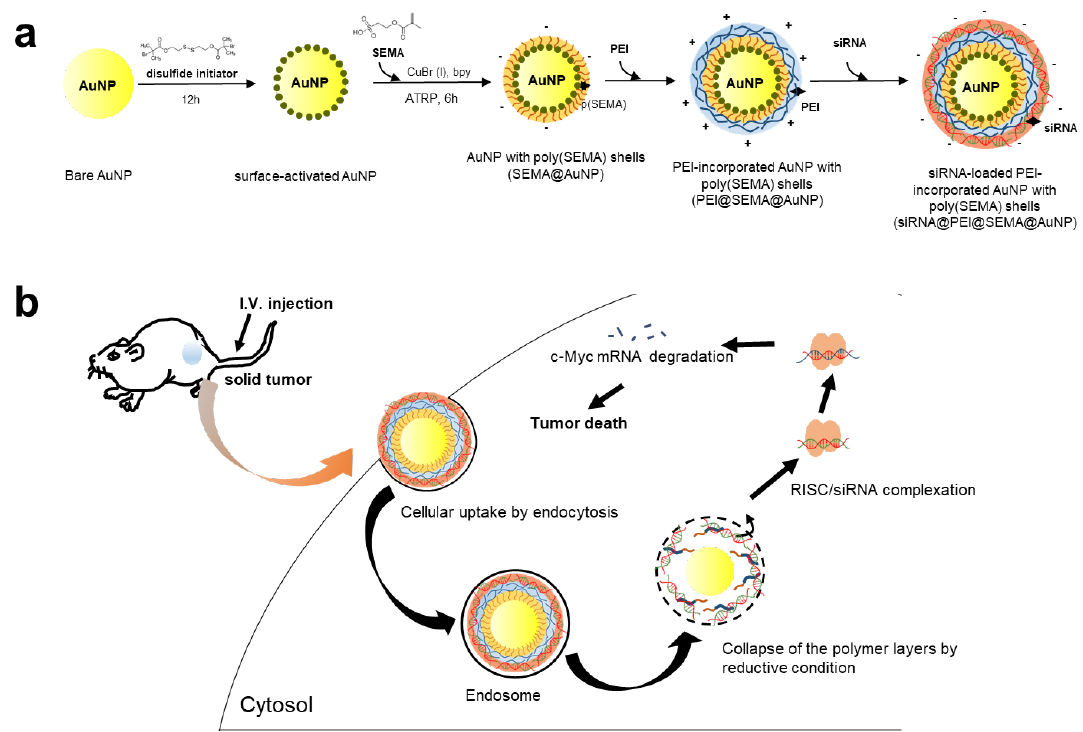
Figure 1. Schematic presentation of preparing and administration of AuNP with siRNA corona for suppression of solid tumors. ( a ) AuNP was anionically modified with surface initiated atom transfer radical polymerization (ATRP) of poly(sulfoethyl methacrylate) (SEMA) (SEMA@AuNP), electrostatically and sequentially incorporated with polyethyeleneimine (PEI) and siRNA